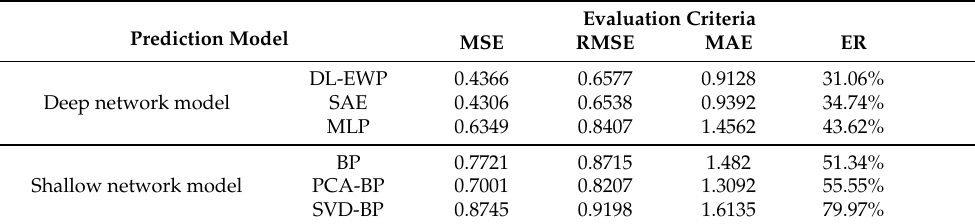
Table 8. Comparison of the prediction performance of the